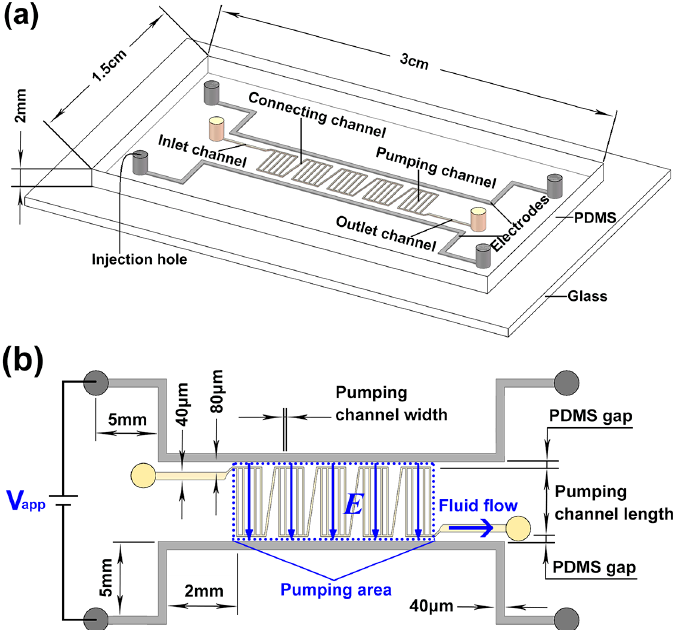
Figure 1. Schematic diagram of five-stage electroosmotic flow (EOF) pump. ( a ) Polydimethylsiloxane (PDMS)/glass microfluidic chip with ohm-shape liquid-metal electrodes. The PDMS slab is 3 cm long, 1.5 cm wide, and 2 mm thick. The chip substrate is a glass slide with 7.6 cm length, 2.5 cm width, and 1 mm thickness; ( b ) The working principle of the EOF pump. The electrode channel is 40 μ m wide with both inlet and outlet 5 mm from the electrode head. The inlet and outlet fluid channels are 2 mm long and 40 μ m wide, which are 80 μ m far from the electrode head. All channels are 20 μ m high. In this pump, the PDMS gap between adjacent two pumping channels has the same size as the width of the pumping channel.